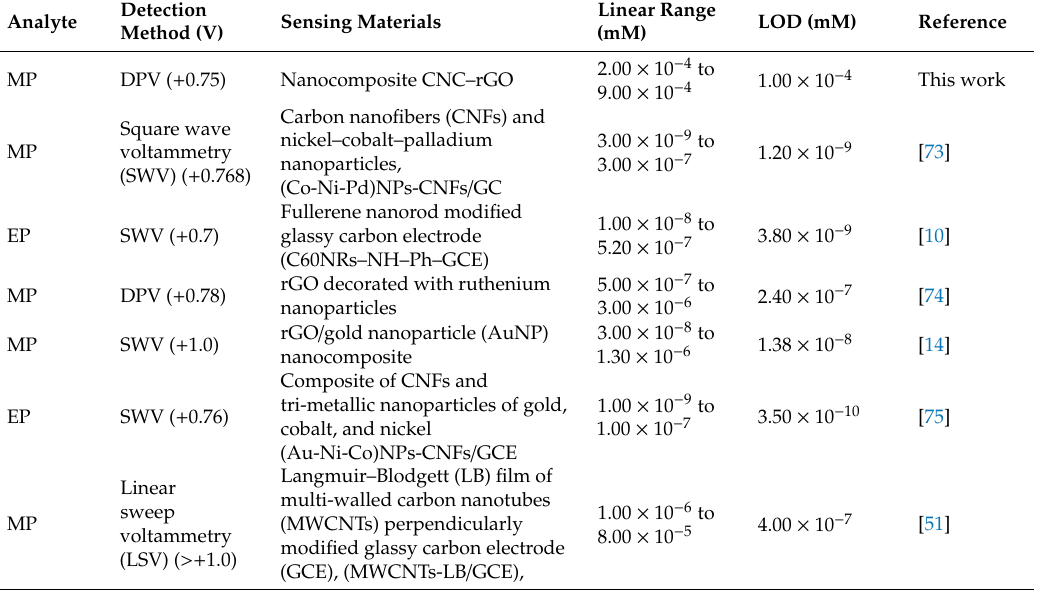
Table 3. Carbon-based electrochemical sensors for paraben detection. LOD—limit of detection; DPV—di ff erential phase voltammetry; EP—ethyl